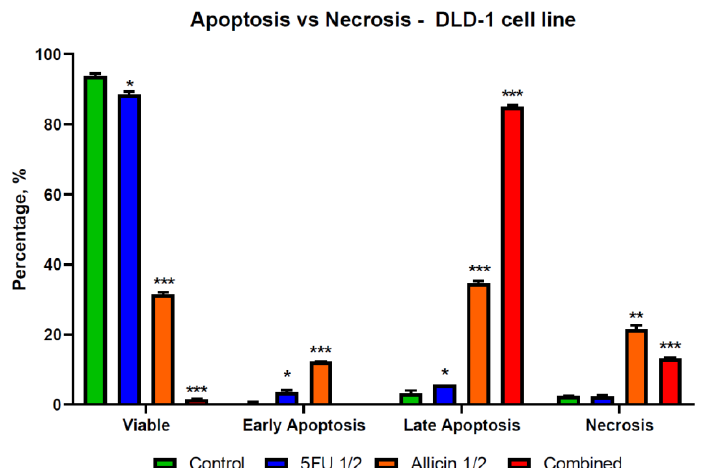
Figure 8. The illustration of apoptosis and necrosis in the DLD-1 cell population. DLD-1 cell line ratio between viable, apoptotic, and necrotic cells, with an increased number of late apoptotic cells for combined treatment. Abbreviations: Control, control group; 5-FU 1 / 2, half of the 5-FU IC 50 -treated group; Allicin 1 / 2, half of the Allicin IC 50 -treated group; Combined, the co-treatment group. The results with p < 0.05 were considered statistically significant (* p < 0.05, ** p < 0.01, and *** p <